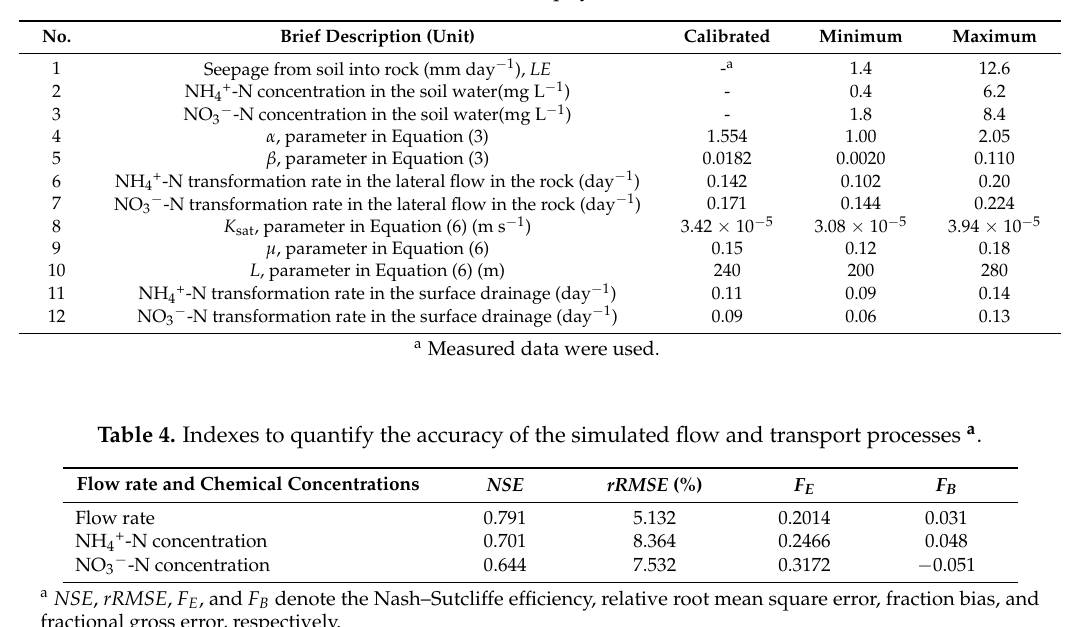
Table 3. Parameter and physical variable list.